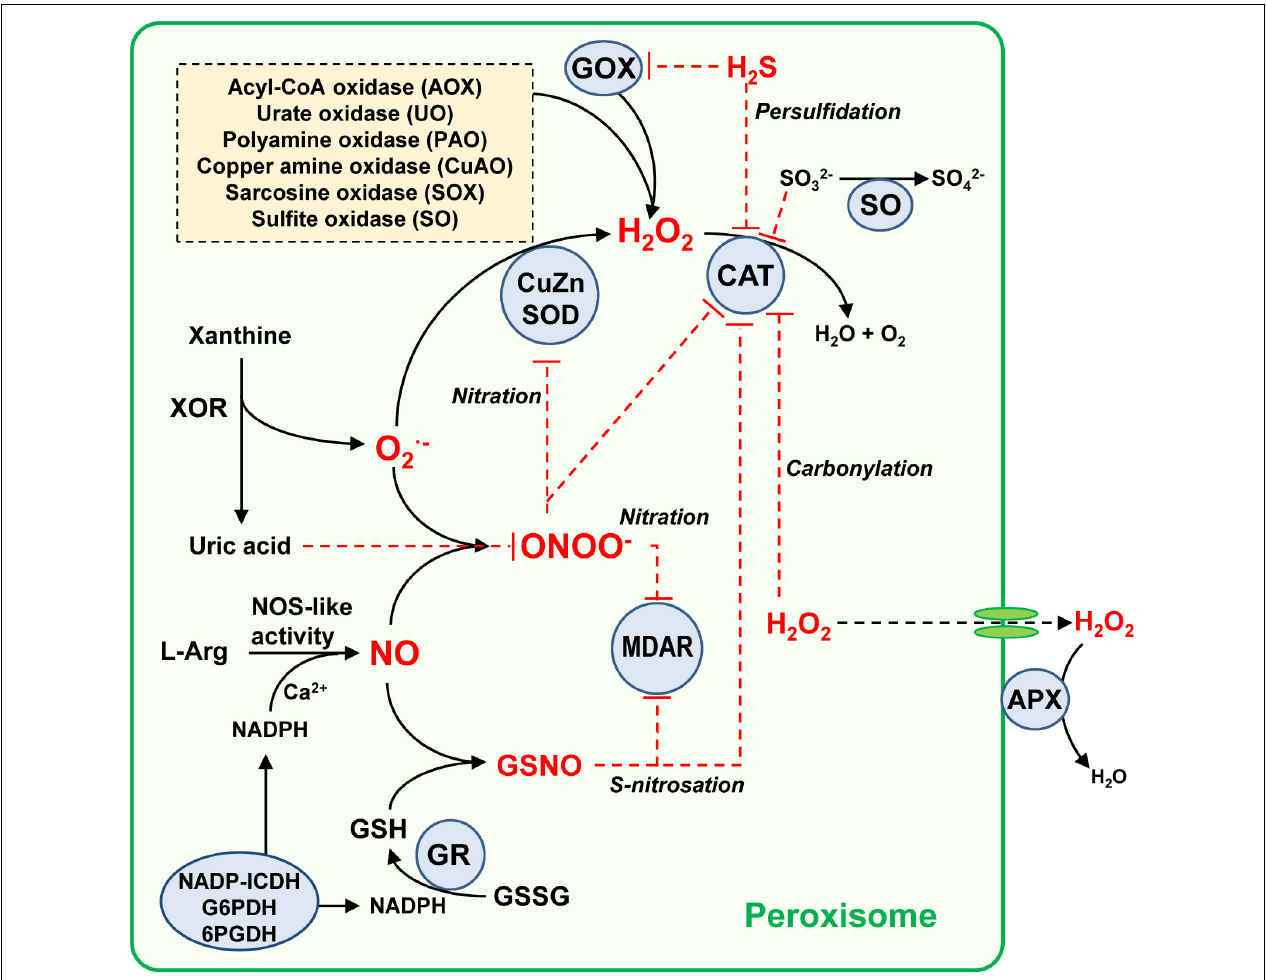
FIGURE 2 | Simple model of the global metabolism of reactive oxygen/nitrogen/sulfur species in plant peroxisomes. Peroxisomes have an important battery of H 2 O 2 -generating enzymes, being the photorespiratory glycolate oxidase (GOX) one of the most relevant. Peroxisomal xanthine oxidoreductase (XOR) activity generates uric acid which the concomitant generation of superoxide radical (O 2 •− ) which is dismutated to H 2 O 2 by superoxide dismutase (SOD). All three SOD types have been described in plant peroxisomes from different origin, CuZ-SOD, Mn-SOD, and Fe-SOD. The H 2 O 2 pool is mainly decomposed by catalase (CAT) but also by the membrane-bound ascorbate peroxidase (APX). An L-arginine (L-Arg) and Ca 2 + dependent NOS-like activity generates NO which can